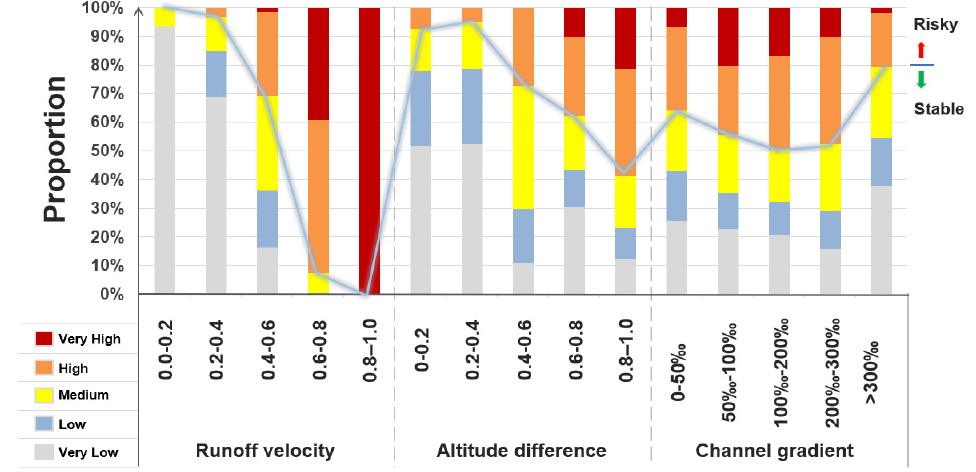
Figure 14. Proportions of the catchments with different debris flow susceptibility obtained by RO- PSO-SVC for each level of different triggering factors.